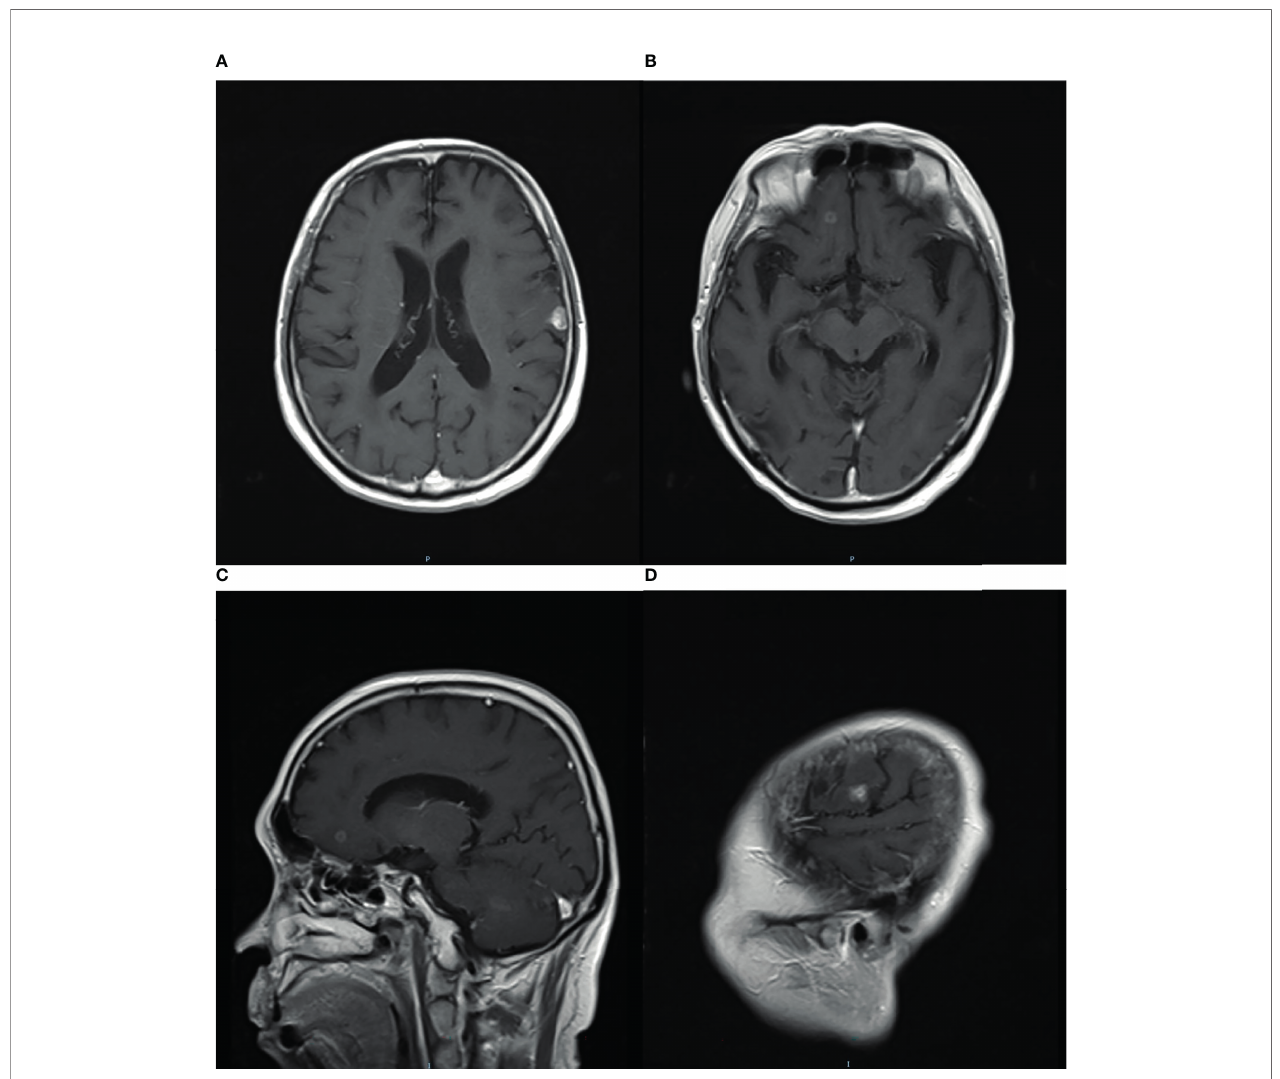
FIGURE 3 | Magnetic resonance imaging (MRI) with contrast enhancement of brain metastasis. (A – D) April 2016, after GK radiotherapy on the brain, new intracranial lesions have been